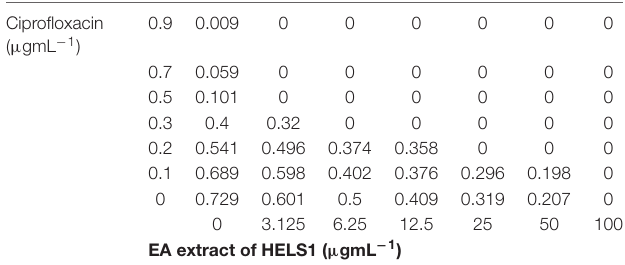
TABLE 2 | Checkerboard-based representation of the cumulative effect of ethyl acetate (EA) fraction of HelS1 and antibiotic ciprofloxacin on the growth of methicillin-resistant Staphylococcus aureus